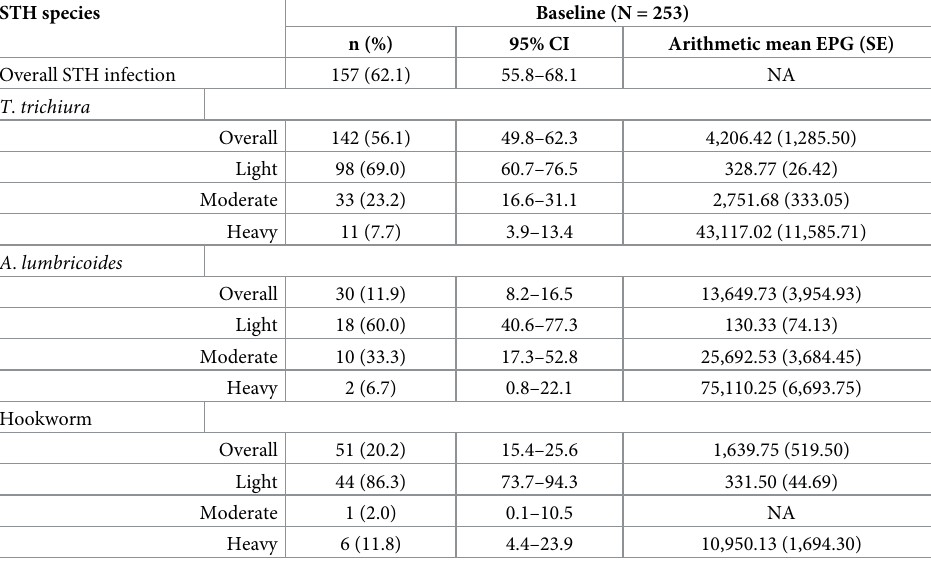
Table 3. Intensity of STH infections of the study population at baseline (N =